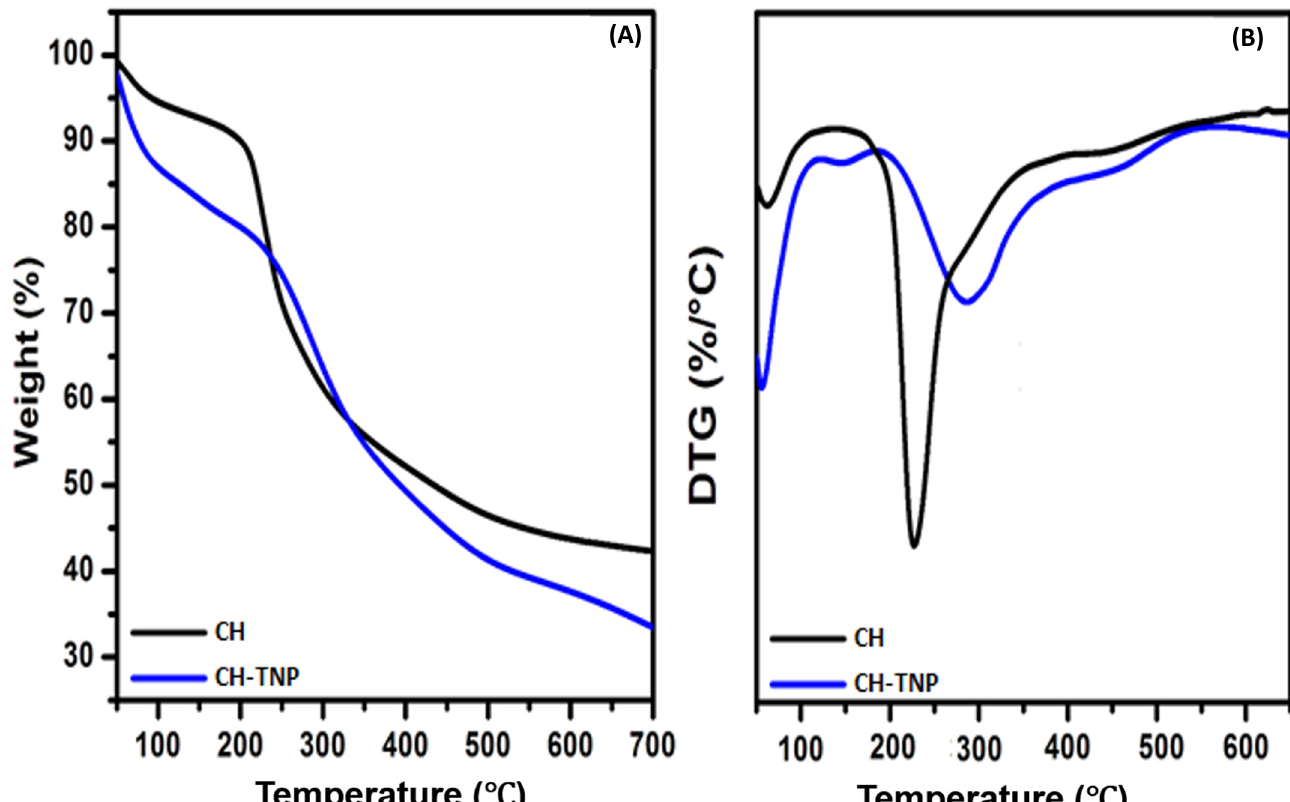
Figure 3. TGA ( A ) and DTG ( B ) plots of CH and CH-TNP.